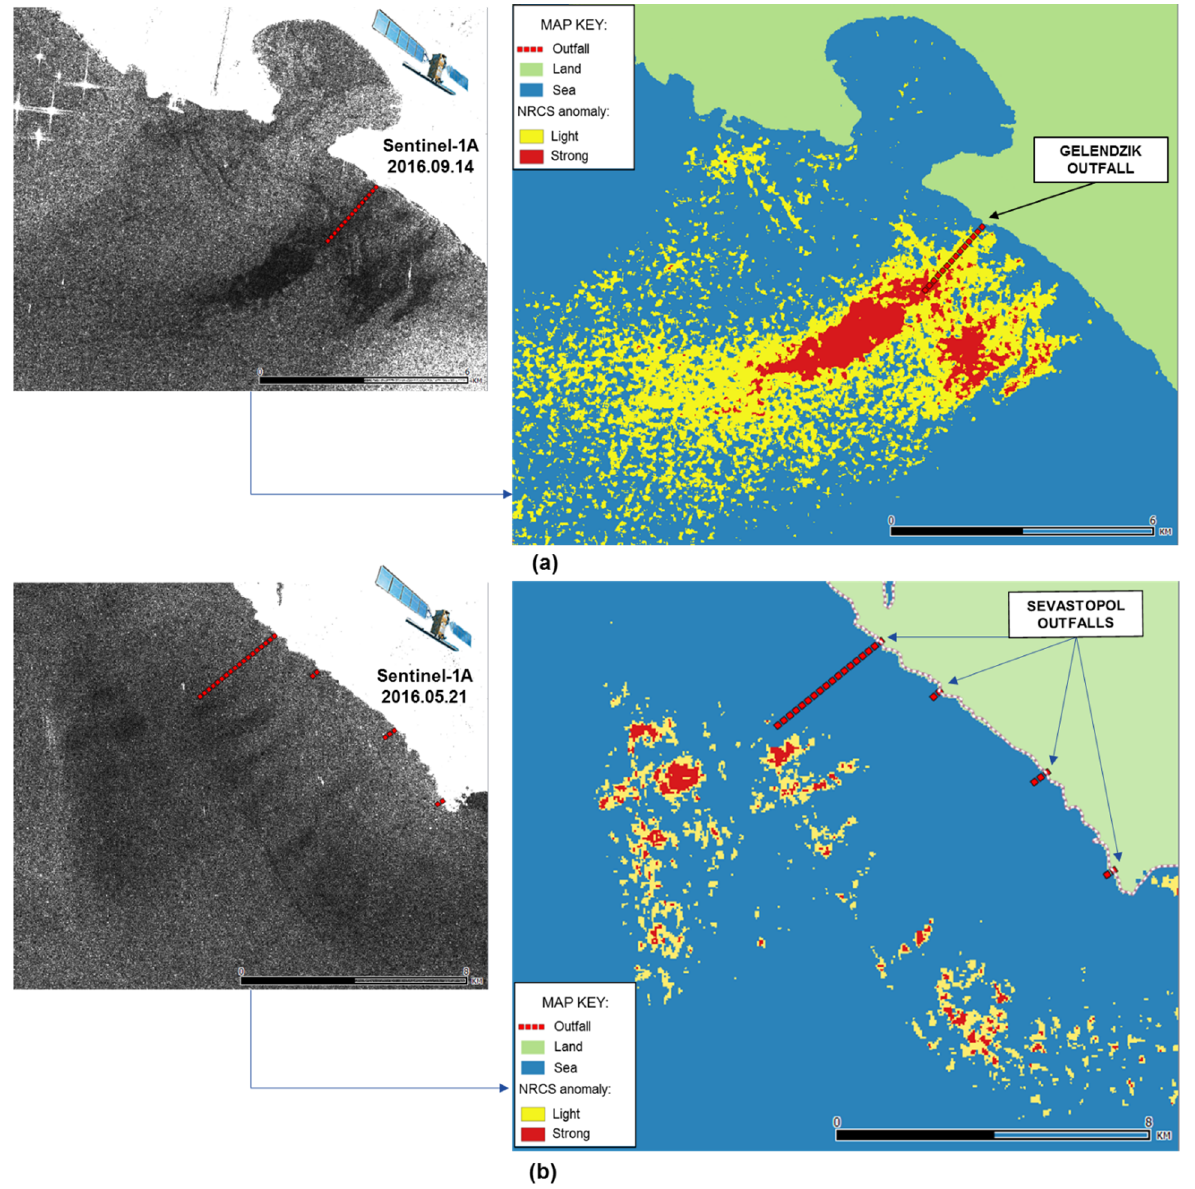
Figure 6. Example processing results for the radar Sentinel-1A image of coastal waters in the northern part of the Black Sea: near the city of Gelendzhik, 21 May 2016 ( a ), and near the city of Sevastopol, 14 September 2016 ( b ).